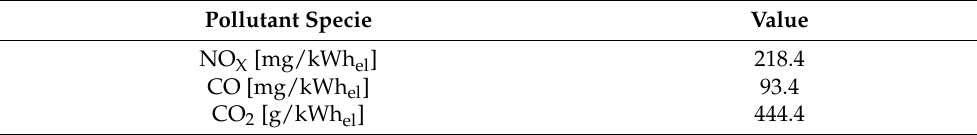
Table 9. National grid emission factor, δ el , i , for pollutant species, reference to 2018 values [42].